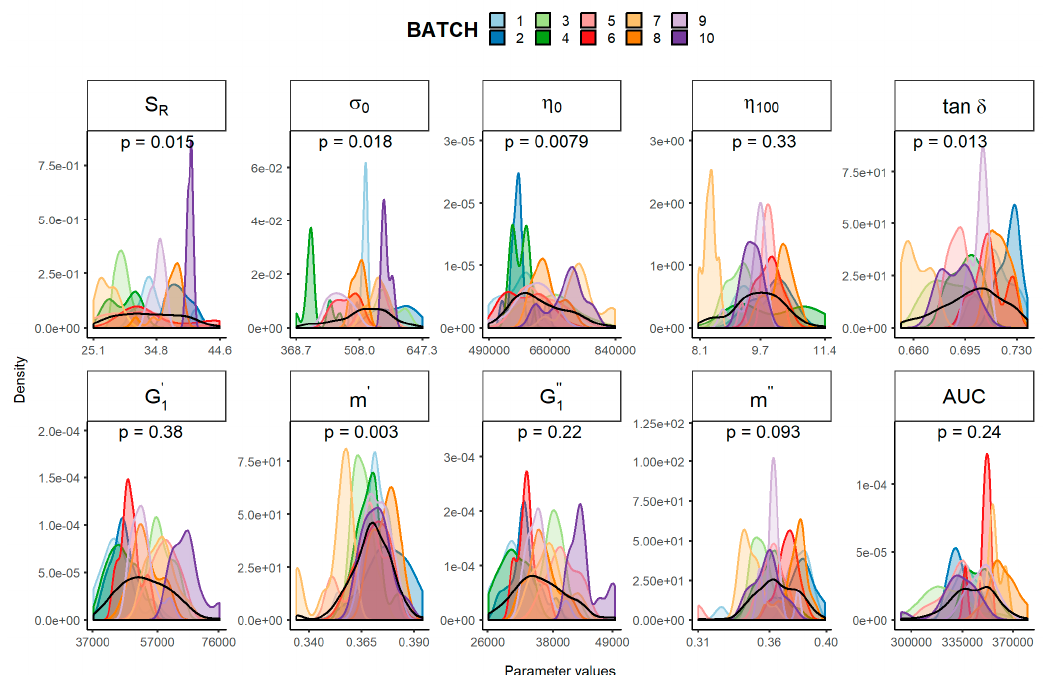
Figure 1. Experimental distribution of each batch (coloured) and overall distribution (black) stratified by the rheological parameters considered. The p value of the Shapiro–Wilk test assesses the normality of the overall distribution. S R , relative thixotropic area; σ 0 , yield stress; η 0 , zero-shear viscosity; η 100 , viscosity at 100 s − 1 ; tan δ , loss tangent at 1 Hz; G (cid:48) , calculated elastic modulus; G (cid:48)(cid:48) , calculated viscous modulus; m’ and m ” are the parameters obtained when fitting G’ and G”, respectively, versus frequency; AUC, area under the surface versus weight curve.